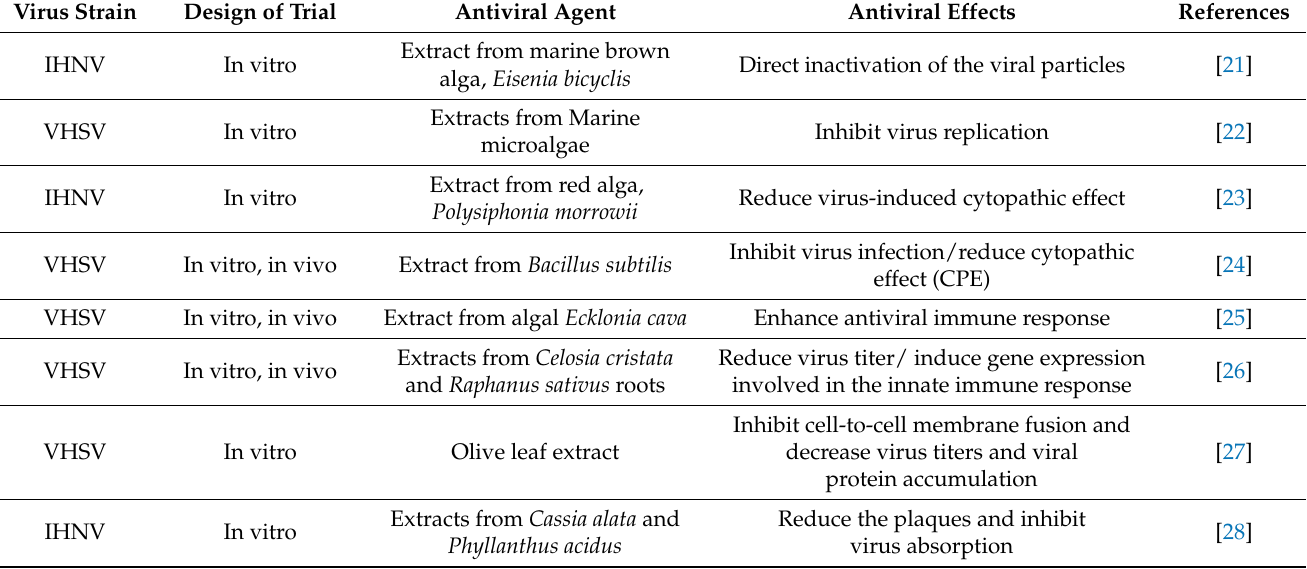
Table 1. Extracts against fish rhabdoviruses and their antiviral